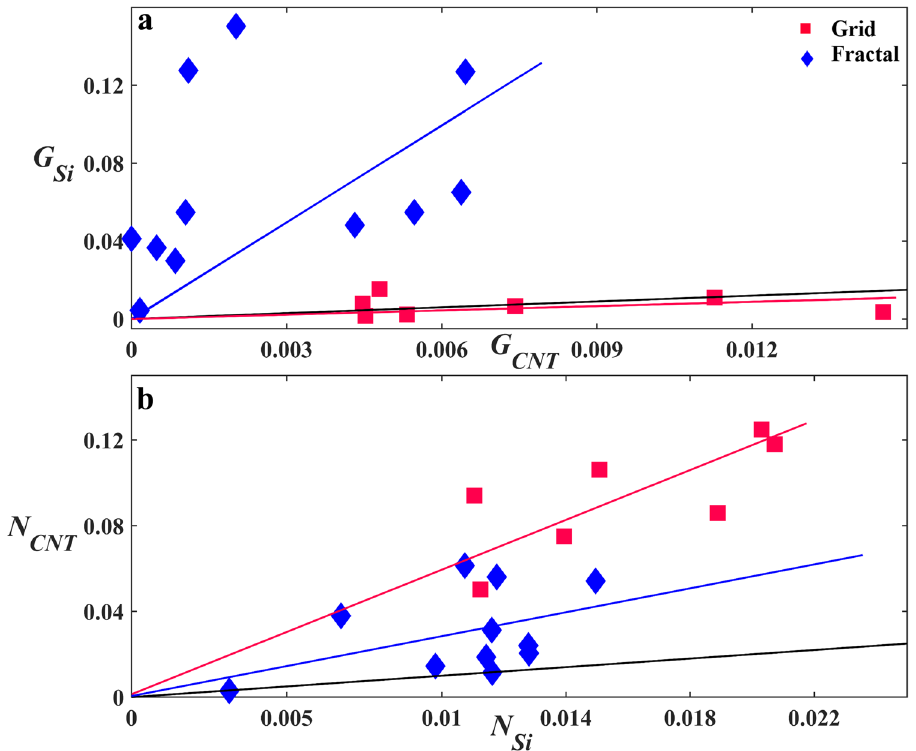
Figure 4. Study of the relationship of G Si with G CNT and N CNT with N Si for the grid and fractal electrodes. ( a ) Scatterplot of G Si versus G CNT for the grids (red) and fractals (blue). ( b ) Scatterplot of N CNT versus N Si for the grids (red) and fractals (blue). The solid black lines represent the G Si = G CNT and N CNT = N Si conditions in ( a ) and ( b ), respectively. The solid red and blue lines are fits through zero for the grids and fractals, respectively.